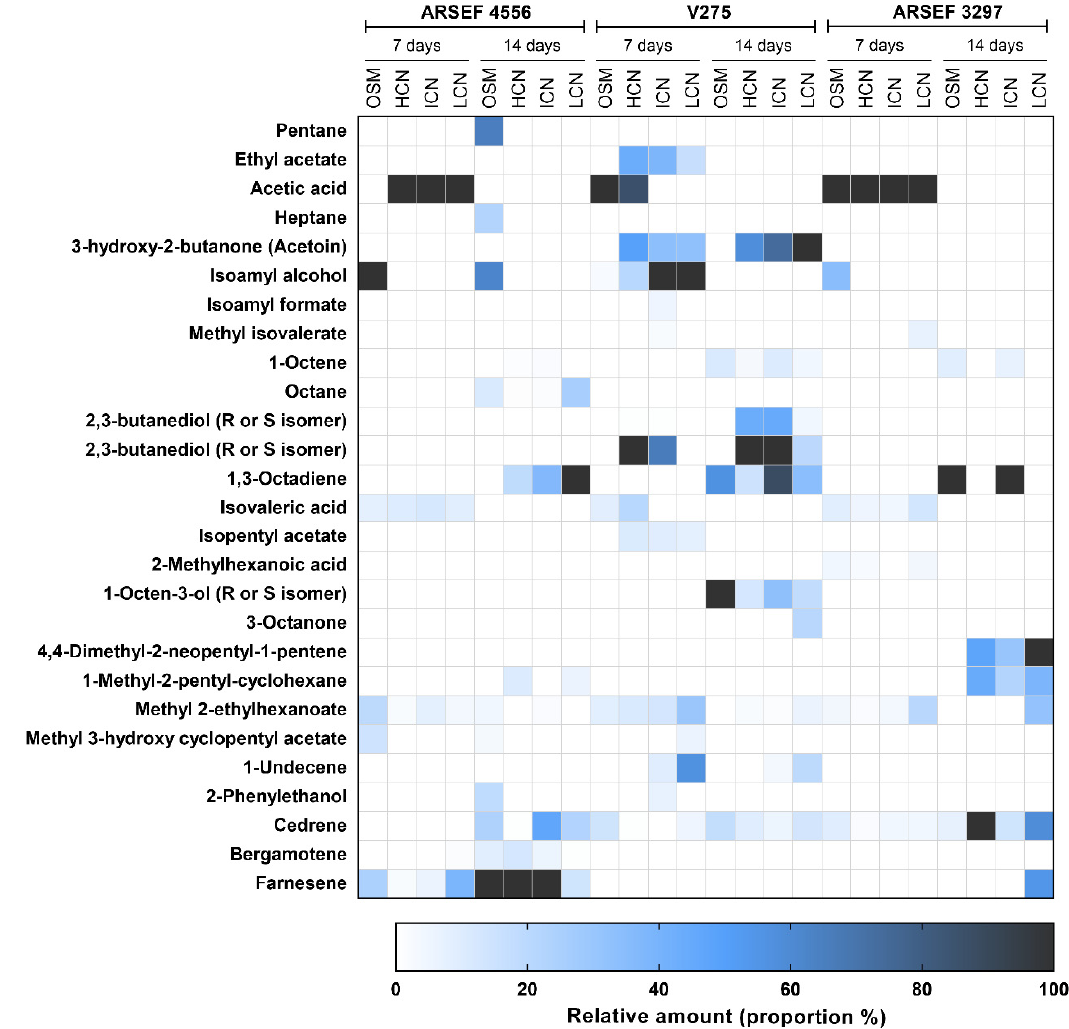
Figure 1. Profiles of volatile organic compounds produced by M. brunneum ARSEF4556, V275 and ARSEF3297 on different substrates. The heatmap represents values that were proportional to the compound with the highest peak (100%) in the chromatogram. n = 5. OSM, osmotic stress medium; HCN, high C:N medium; ICN, intermediate C:N medium; LCN, low C:N medium. Note: no conidia were present in the ARSEF 4556 at 7 days.